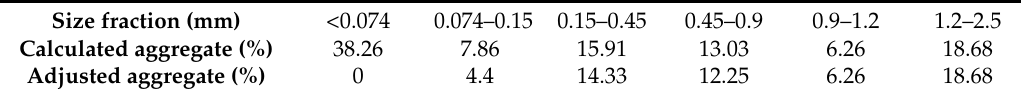
Table 3. Particle-size distributions of calculated and adjusted aggregates.